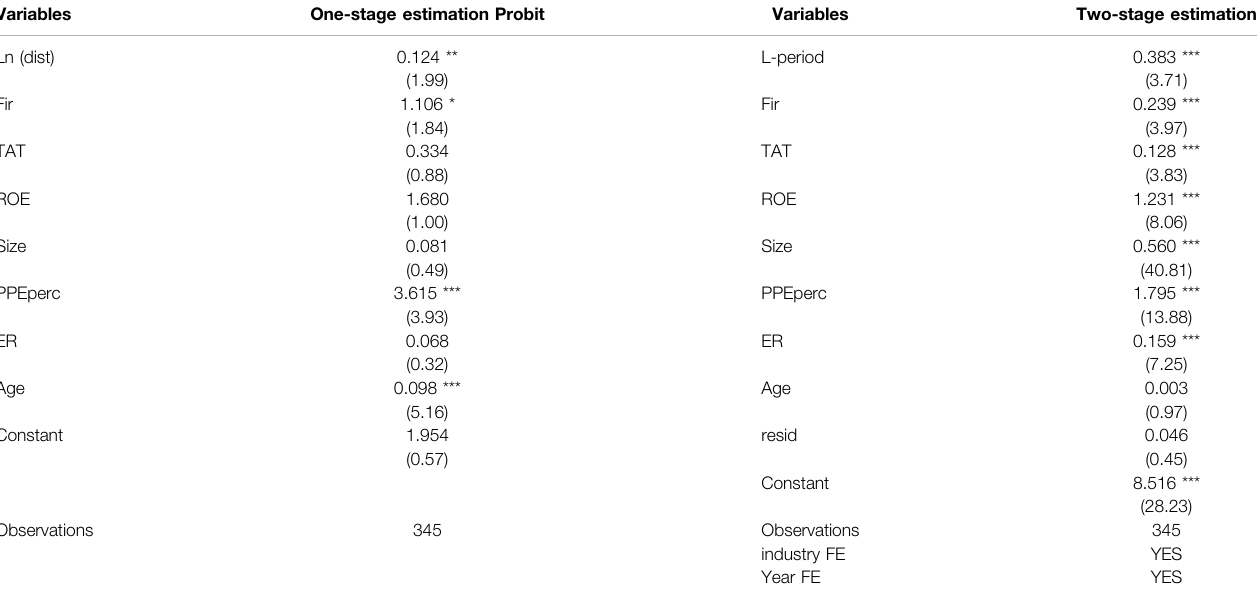
TABLE 5 | The relationship between innovation performance and late involvement of venture capital.